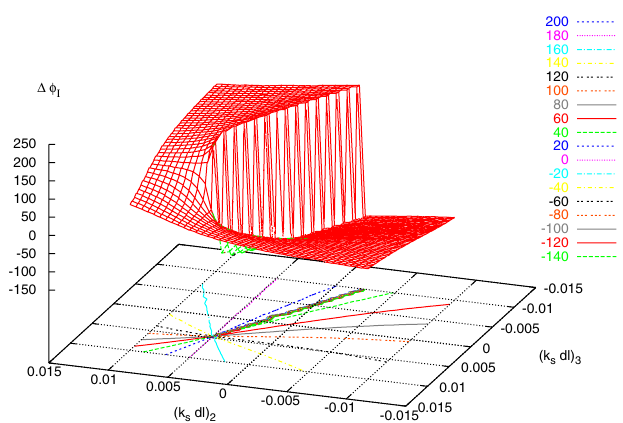
FIG. 3. (Color) Projection phase difference (cid:1) (cid:2) pling